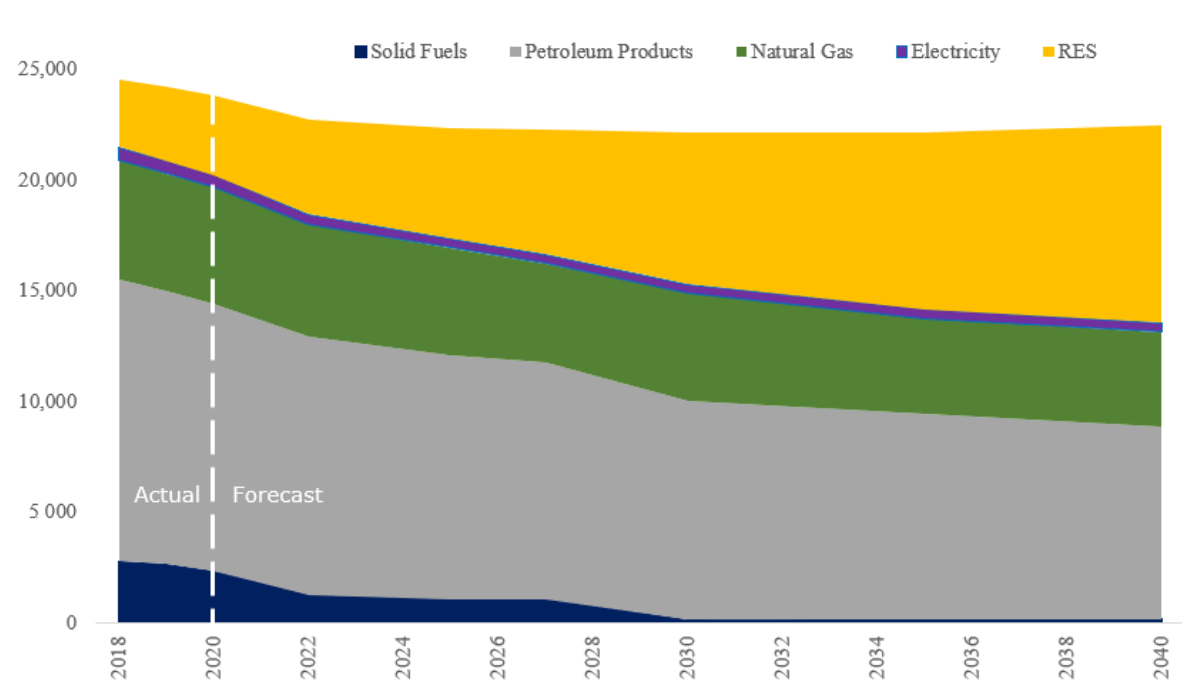
Figure 1. Evolution of Gross Energy Consumption in Greece (ktoe), (2018–2040) , Source: National Energy and Climate Plan (2020) and Authors’